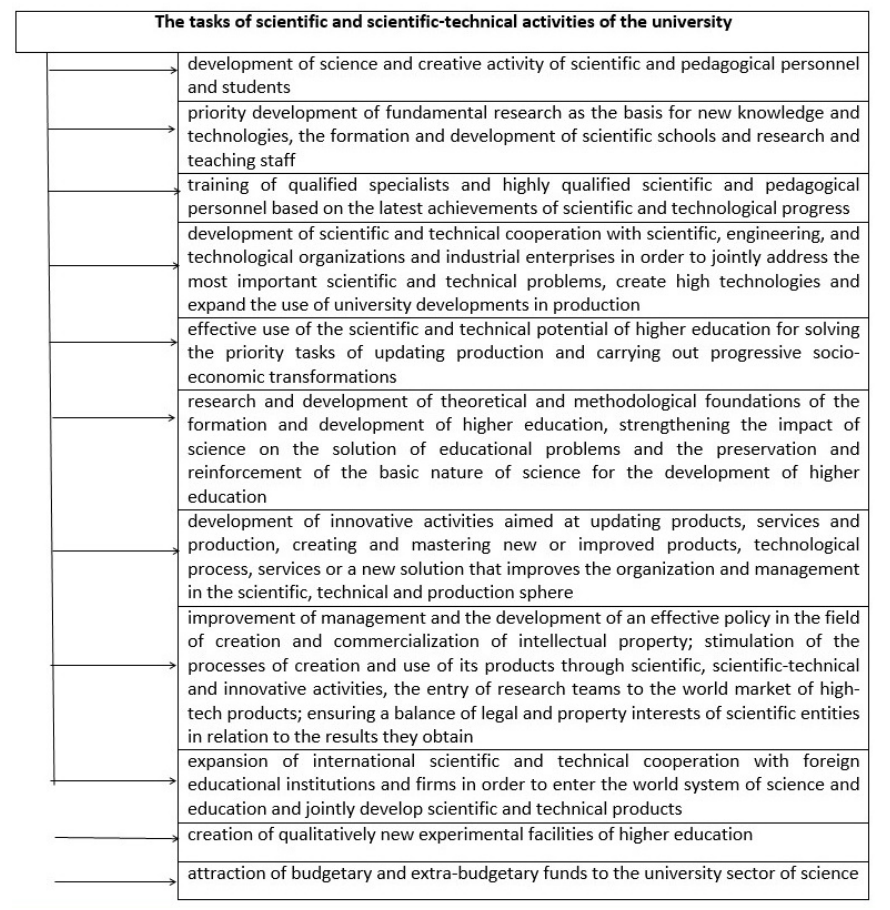
Fig. 2. Basic tasks of scientific and scientific-technical activities of